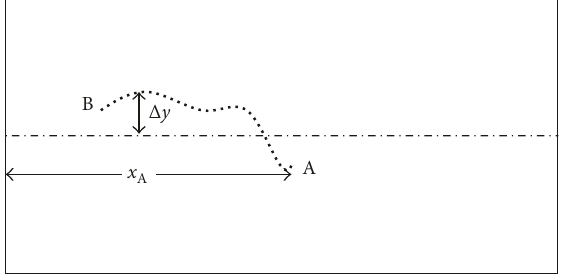
Figure 10: Illustration of free fiber in jet